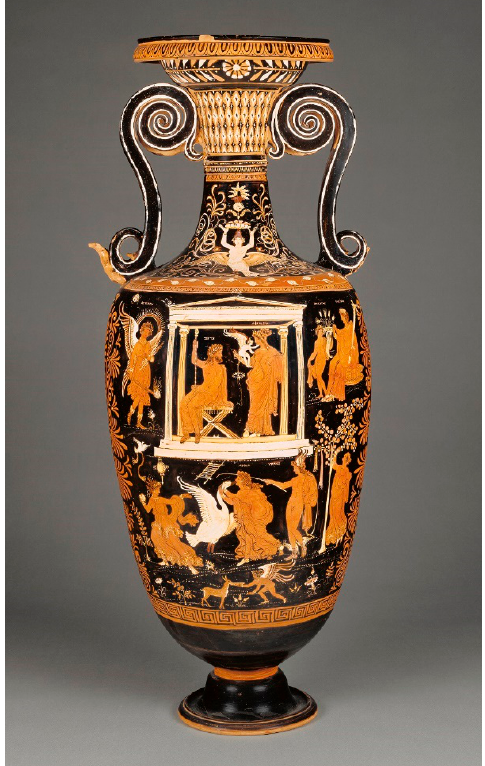
Figure 3. Malibu, J. Paul Getty Museum 86.AE.680 Apulian loutrophoros, Painter of MNB 1148, ca. 330 B.C. Siren in floral surround (neck), Zeus and Leda (body). Digital image courtesy of the Getty Open Content Program.